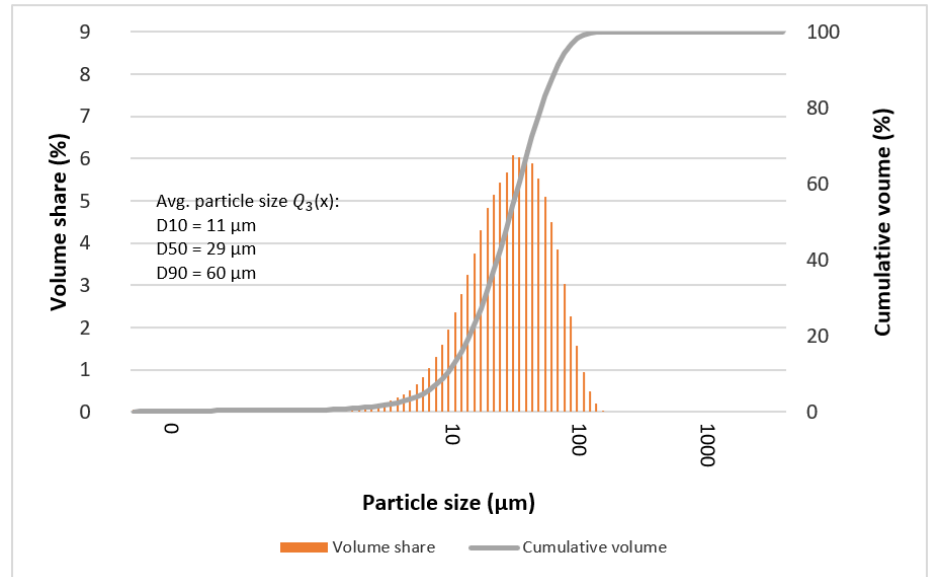
Figure 10. Graphs of particle size distributions (histograms) and their cumulative distribution (curve) for Mg 65 Zn 30 Ca 4 Ag 1 alloys after 70 milling hours.